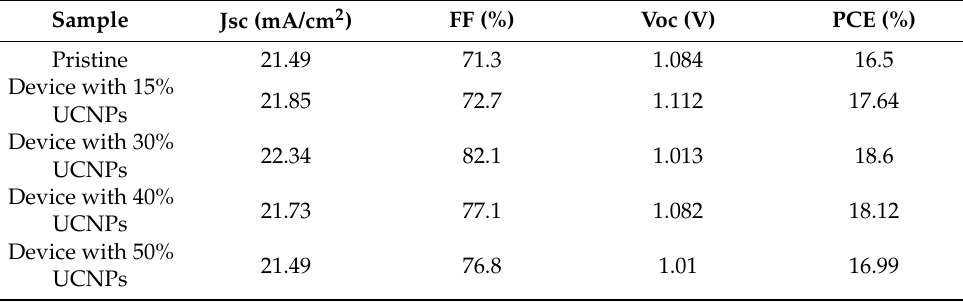
Table 1. Photovoltaic parameters of the fabricated